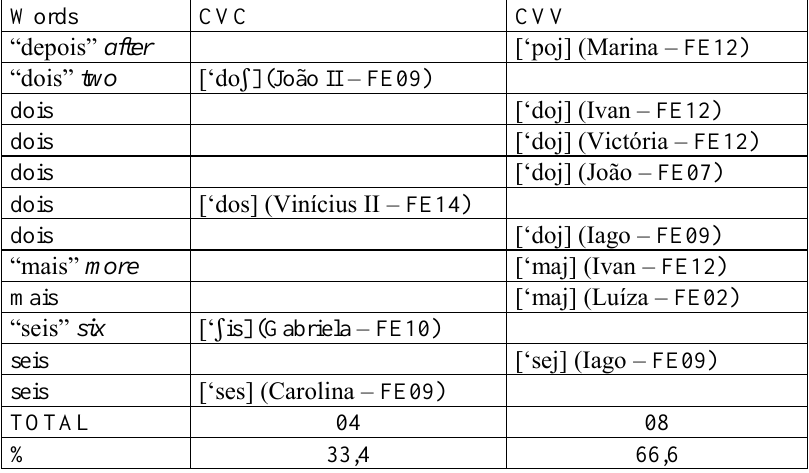
Table III – CVC and CVV syllable structures production for CVVC